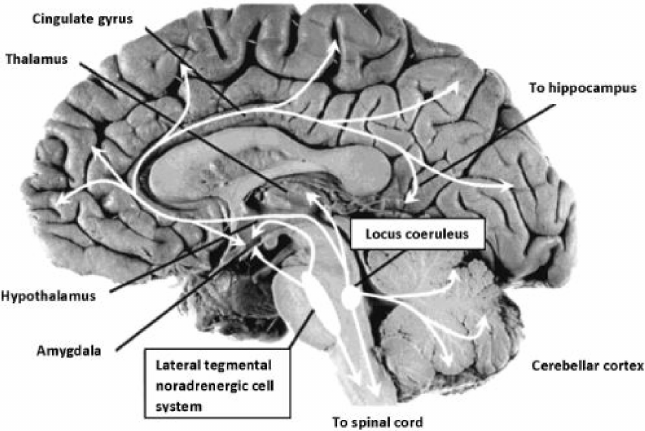
Figure 2. Noradrenergic projections from the locus coeruleus, site of synthesis of NE, modulate CN II & CNIII, controlling the PLR. LC neurons located in the pons project to subcortical structures associated with hyperarousal modulating neural activity and extend throughout cortex also directly effecting pupillary response to a light stimulus. Image reproduced from Strawn & Geracioti (2008).